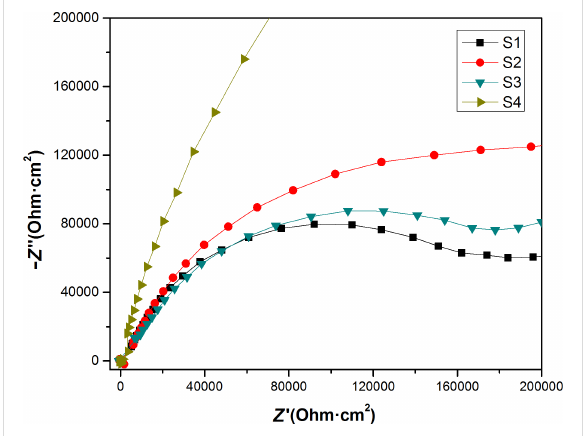
Figure 9: The zoomed portion of the high-frequency region of the Nyquist diagram for the various prepared samples.